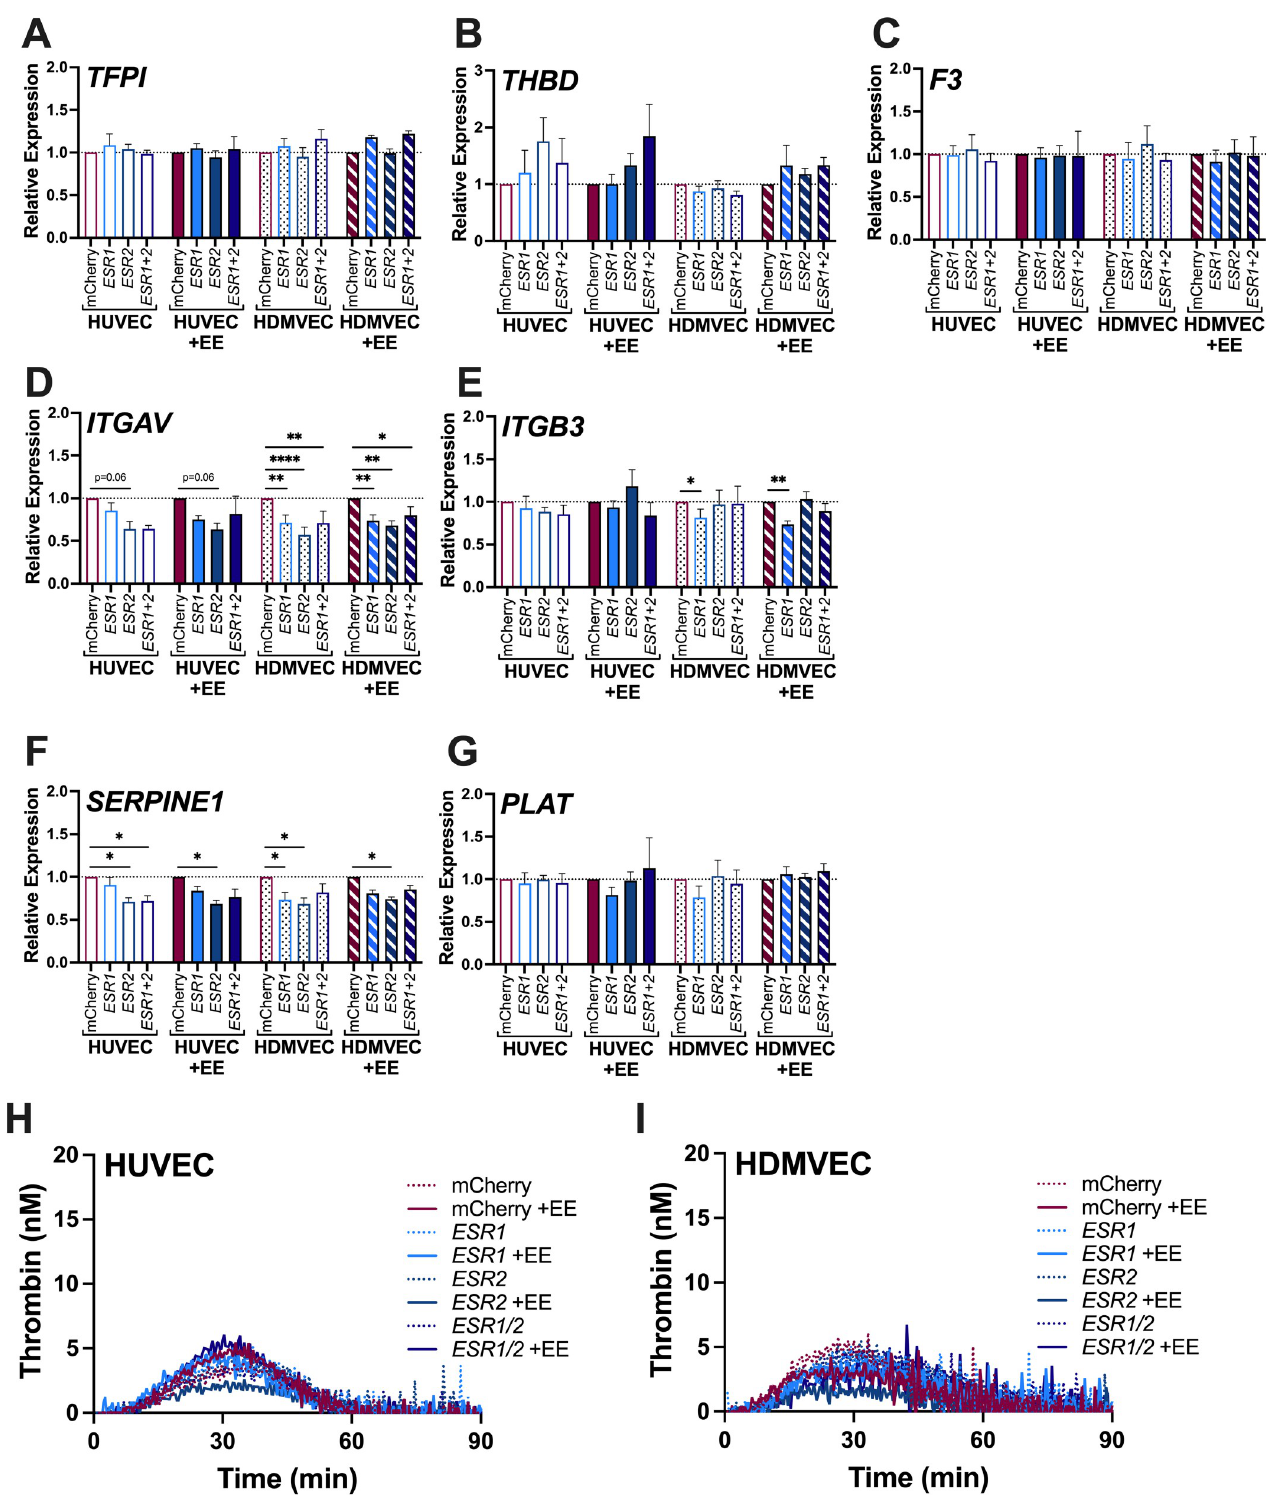
Fig 5. Overexpression of ESR1 and ESR2 in HUVEC and HDMVEC does not facilitate a prothrombotic response to EE. Transcript expression of (A) TFPI , (B) THBD , (C) F3 , (D) ITGAV , (E) ITGB3 , (F) SERPINE1 , and (G) PLAT was measured by RT-qPCR following 72 hours lentiviral transduction and 24 hours of subsequent EE treatment (N = 4; Bars = mean + SEM; * p < 0.05, ** p < 0.01, *** p < 0.001, **** p < 0.0001). Thrombin generation in NPP stimulated by (H) HUVEC or (I) HDMVEC treated with lentiviral vector and EE (single curves representative of N = 4 experiments in duplicate). Thrombin generation parameters and statistical analyses are provided in S2